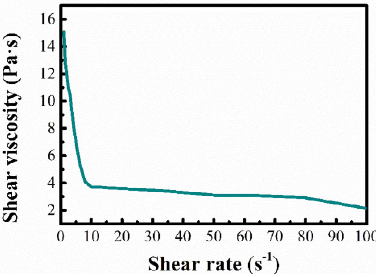
Fig. 3 Viscosity vs. shear rate behavior of the 40 vol% HA slurry.